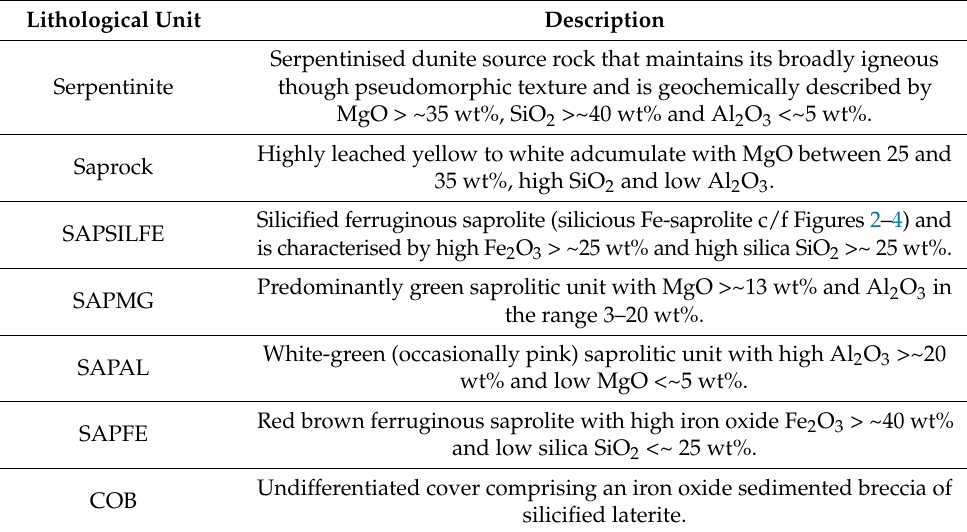
Table 3. Definitions of the lithological units used in this work.